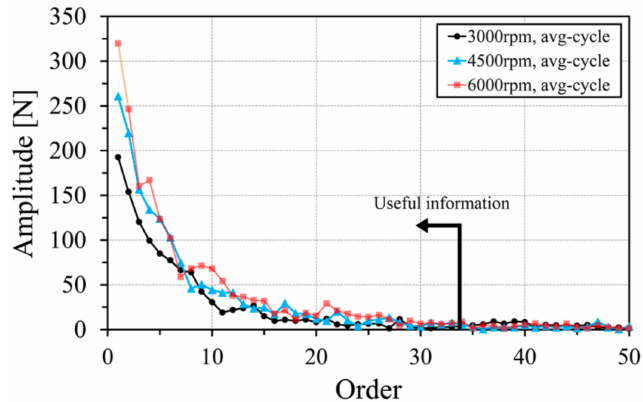
Figure 6. FFT spectrum of the strain washer signal at full load and different engine speeds.